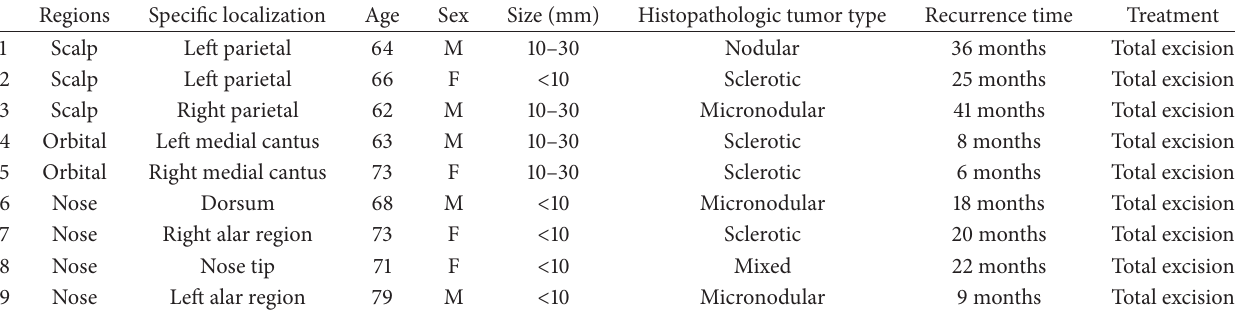
Table 3: Clinical features of recurrent